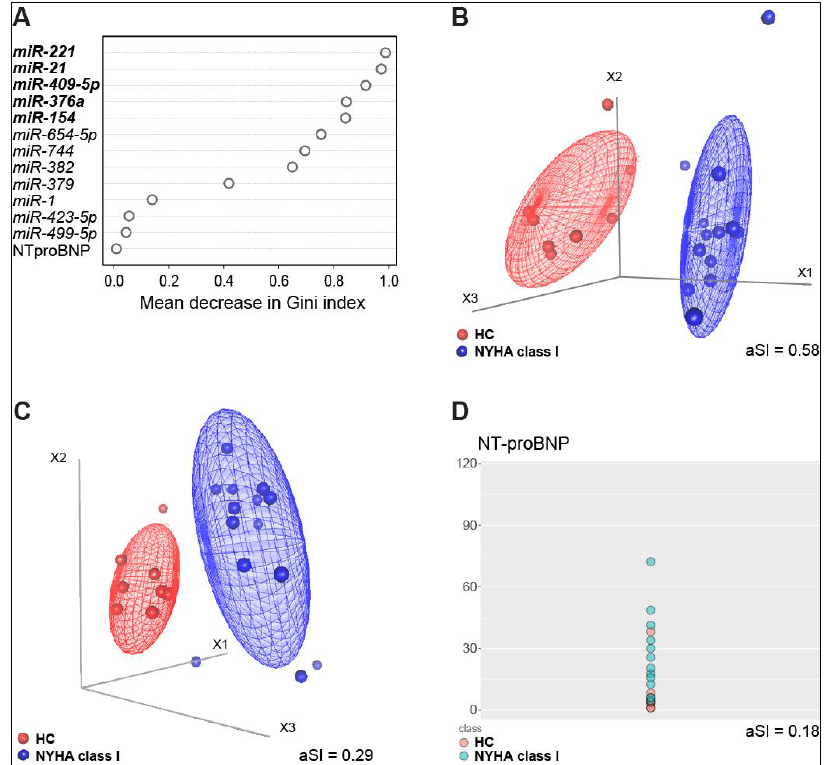
Figure 5. Expression levels of plasma miR-499-5p are associated with the VO 2 peak. HF-regulated miR-499-5p showed a negative association with VO 2 peak levels. Analyses were adjusted for age, sex, personal history of diabetes mellitus, hypertension, and/or hypercholesterolemia, and smoking habit. Trendlines are depicted along with the 95% confidence interval (light gray). p adj = p -values corrected for multiple comparisons; n = 61.